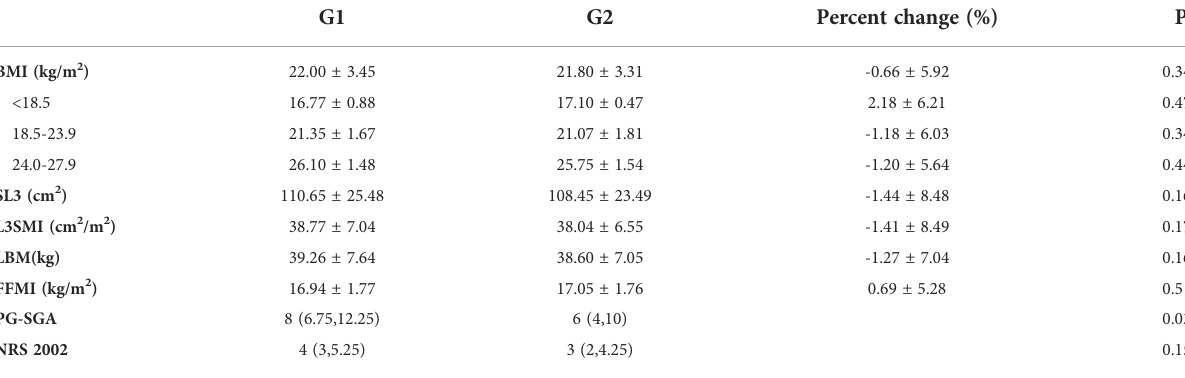
TABLE 2 Comparison of body composition related indicators between G1 and